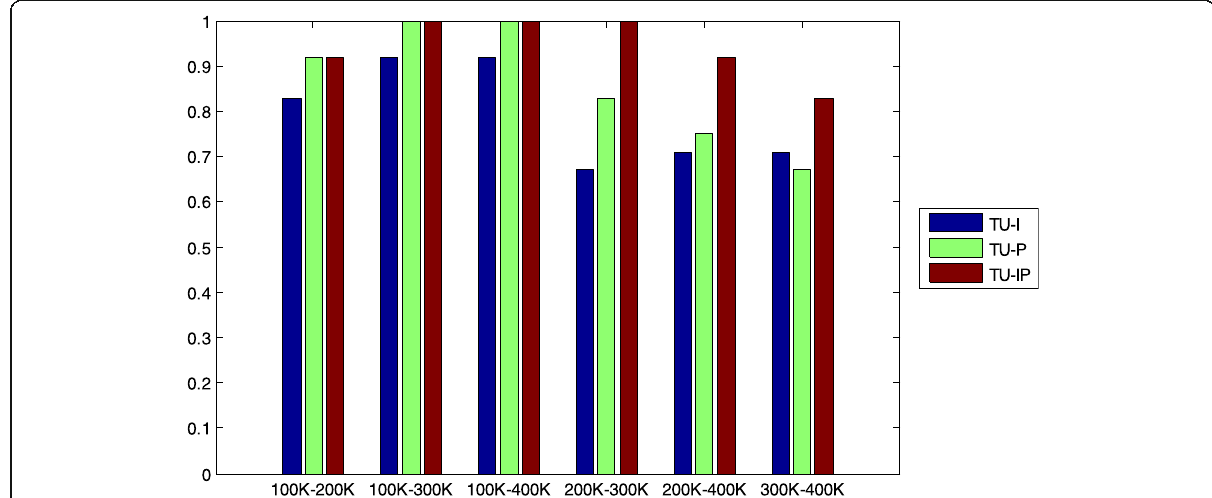
Fig. 7 The median value (MED) of detection accuracy of TU-I, TU-P, and